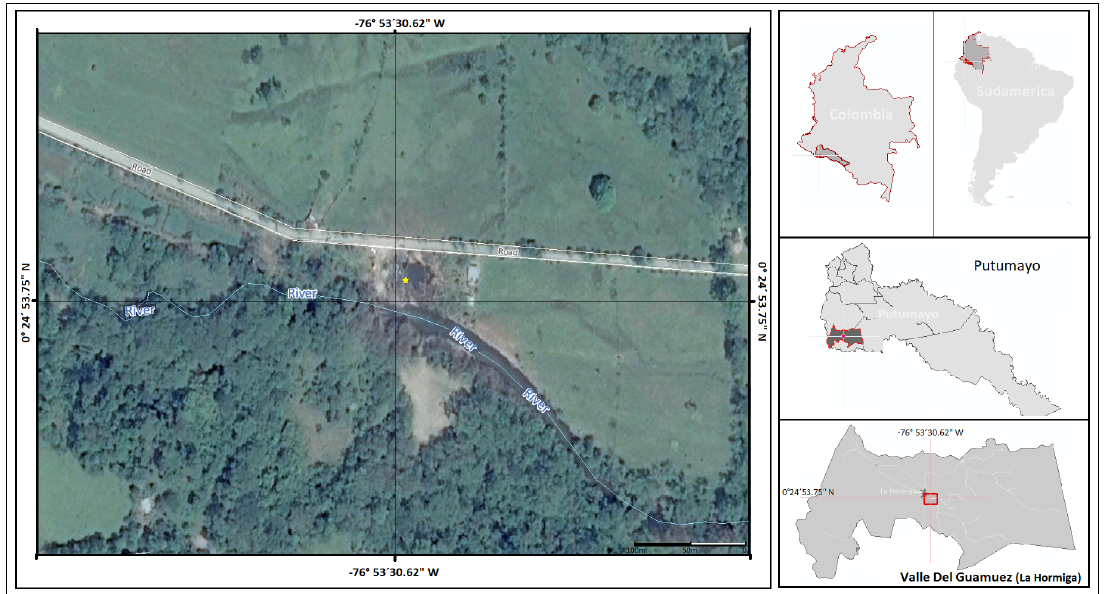
Figure 1. Soil sampled site at the Valle del Guamuez municipality (near to Hormiga River), in the Putumayo region, Colombia (South